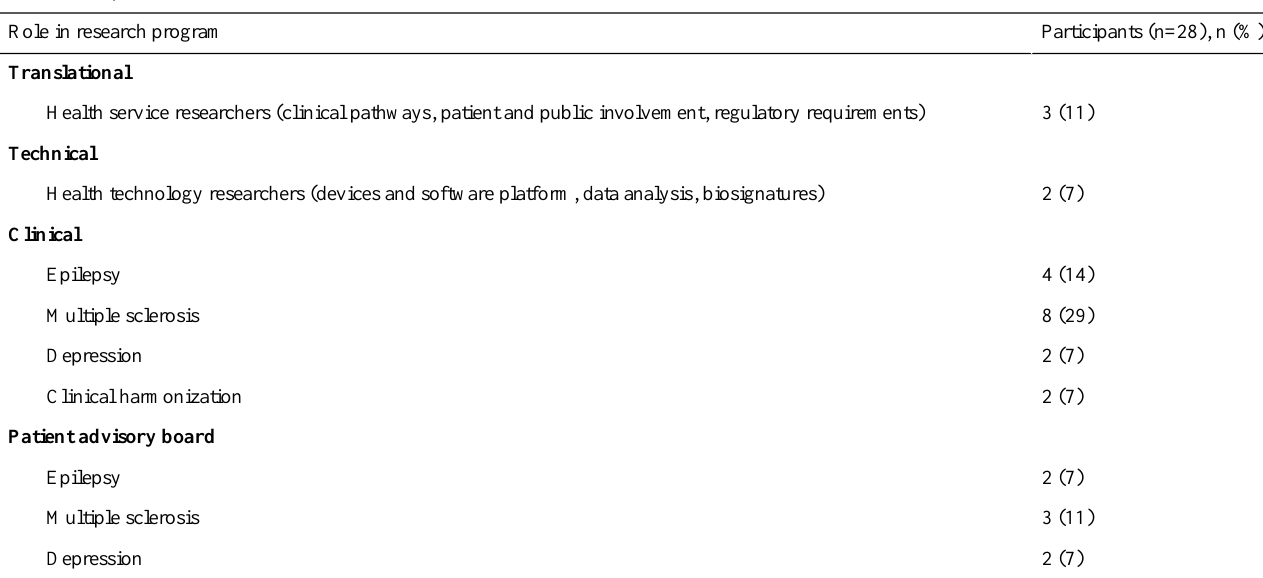
Table 2. Respondent roles in the consortium.